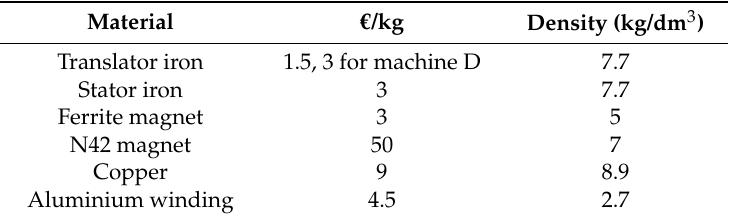
Table 2. Material costs in € /kg and